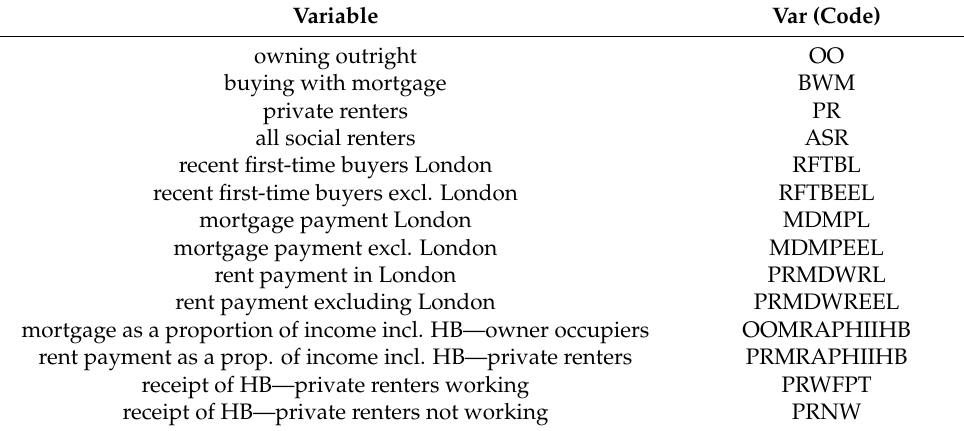
Table 1. Variables used in the